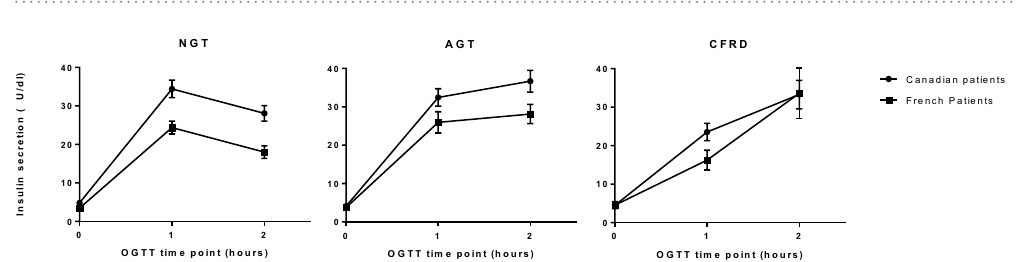
Figure 3. Mean FEV1 change in FEV 1 according to glucose tolerance subgroup and cohort. Values are presented as mean ± SEM. Abbreviations: AGT: abnormal glucose tolerance, CA: Canadian patients, FR: French patients, NGT: normal glucose